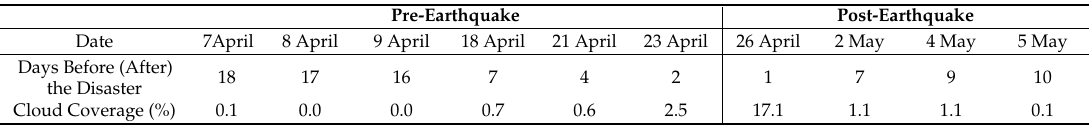
Table 2. The dates and cloud coverages of pre- and post-earthquake Day/Night Band (DNB) images of the Gorkha Nepal Earthquake in